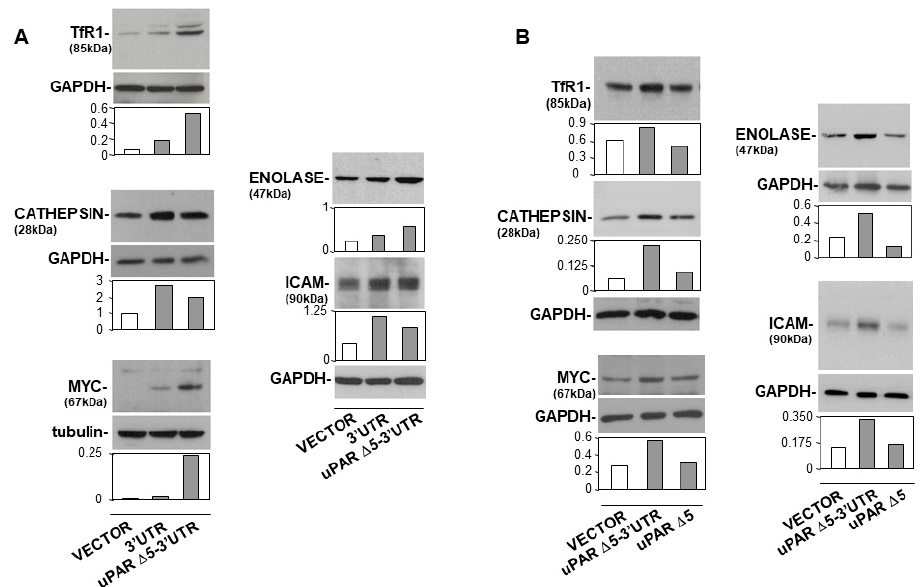
Figure 4. uPAR ∆ 5 variant regulates the expression of pro-tumoral factors. ( A ) KG1 cells were transfected with uPAR ∆ 5-3 (cid:48) UTR or with the empty vector or the 3 (cid:48) UTR of uPAR, as a negative and positive control, respectively; after 24 h cells were lysed. An amount of 20 µ g of cell lysates was analysed by Western blot with MYC, TfR1, Enolase, Cathepsin specific antibodies. The filter hybridized with the anti-Enolase antibody was re-hybridized with an anti-ICAM antibody. All filters were then re-probed with rabbit anti-GAPDH or mouse anti-tubulin antibodies as a loading control. Detected bands were analysed by densitometric scanning and the O.D. corresponding to specific bands were normalized to the O.D. of corresponding GAPDH or tubulin bands. ( B ) KG1 cells were transfected with the cDNA of uPAR ∆ 5 carrying (uPAR ∆ 5-3 (cid:48) UTR) or not (uPAR ∆ 5) the 3 (cid:48) UTR, or with the empty vector. An amount of 20 µ g of cell lysates was analysed by Western blot with MYC, Cathepsin, Enolase and ICAM specific antibodies; the filter hybridized with the anti-Cathepsin antibody was re-hybridized with the anti-TfR1 antibody. All filters were then re-probed with a rabbit anti-GAPDH antibody as loading control. Detected bands were analysed by densitometric scanning and the O.D. corresponding to specific bands were normalized to the O.D. of corresponding GAPDH bands. Original Western Blots can be found at supplementary materials.